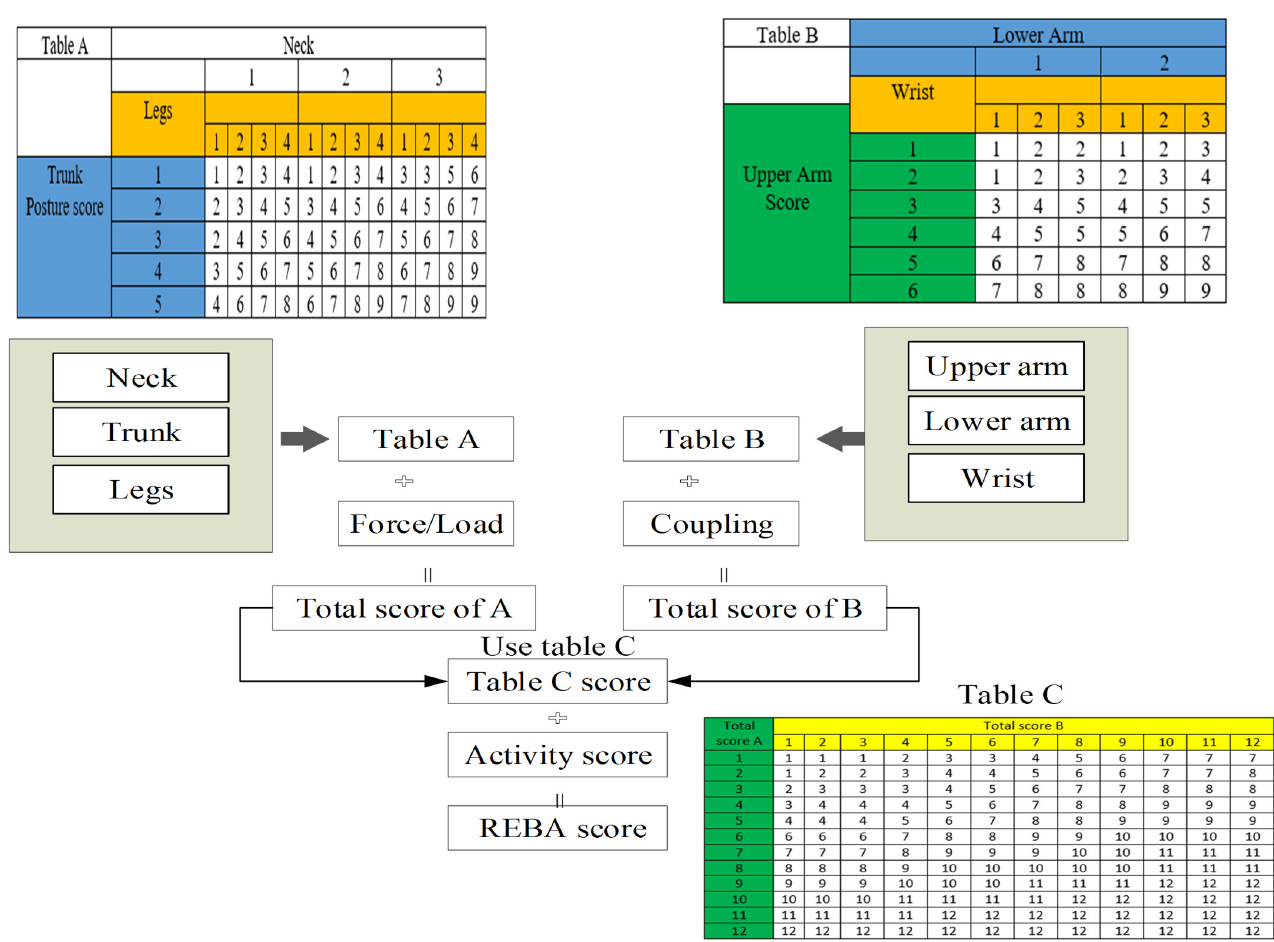
Figure 8. Standard scoring sheet for REBA.